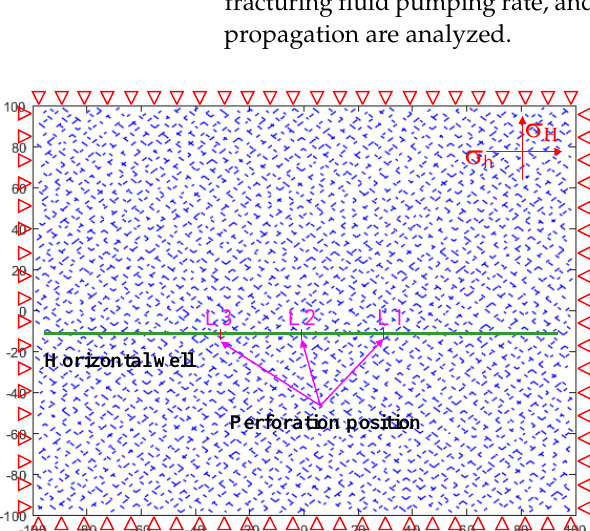
Figure 7. Schematic diagrams of the staged fracturing model for horizontal wells in CBM reservoirs (x-axis and y-axis are the horizontal and vertical dimensions (m)).